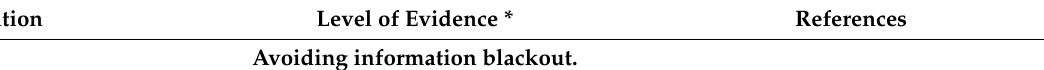
Table 2. Interventions aimed at strengthening work